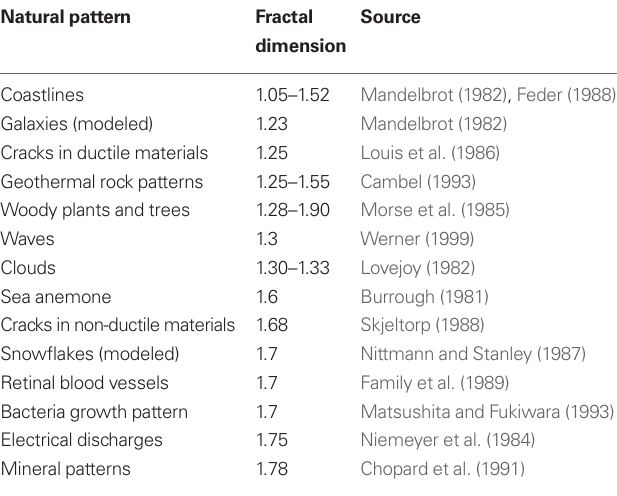
Table 1 | D values for various natural fractal